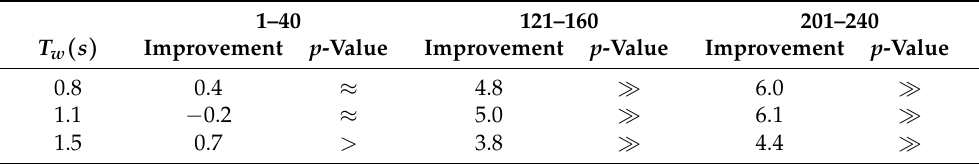
Table 2. Accuracy improvement for FBCCA by percentage and paired t -test.